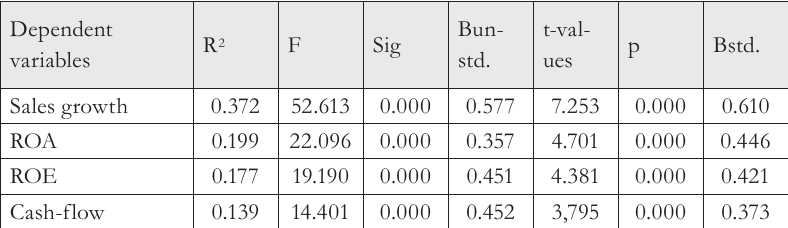
Tab. 5 – The results of the regression model for the financial performance outcomes of strate- gic management tools and techniques utilization. Source: Own calculations.